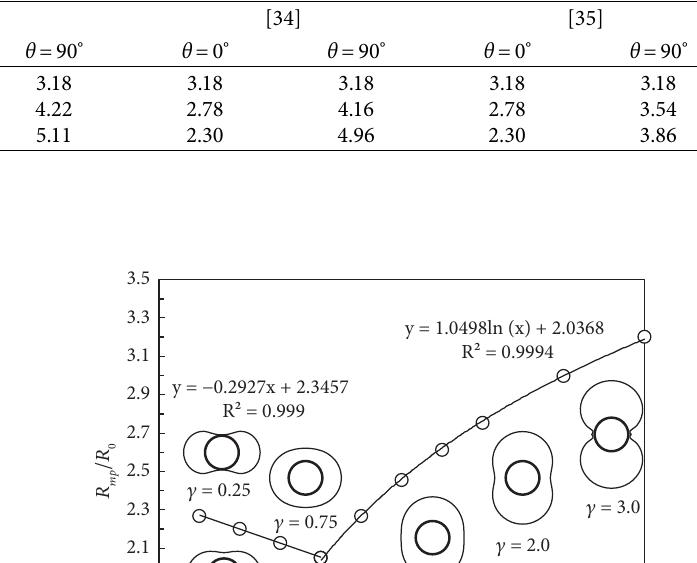
Table 1: Ratio results of the plastic zone radius and the tunnel radius ( R